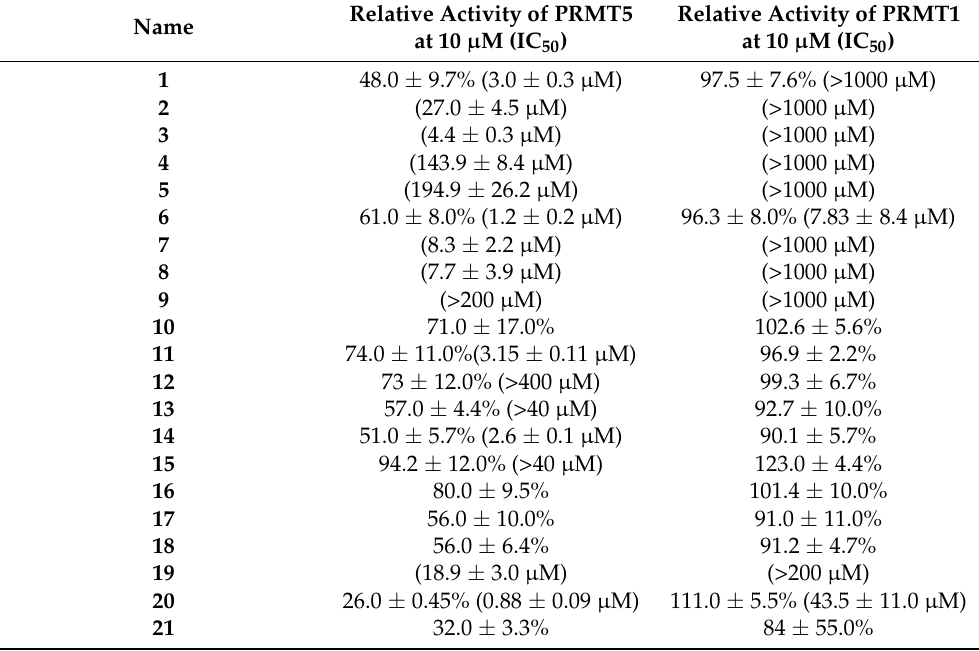
Table 1. Activities of analogs measured in the single point SPA test at 10 µ M against PRMT5 and PRMT1, with activities reported as the remaining activity of the enzyme in a percentage. IC 50 (if determined) is listed in